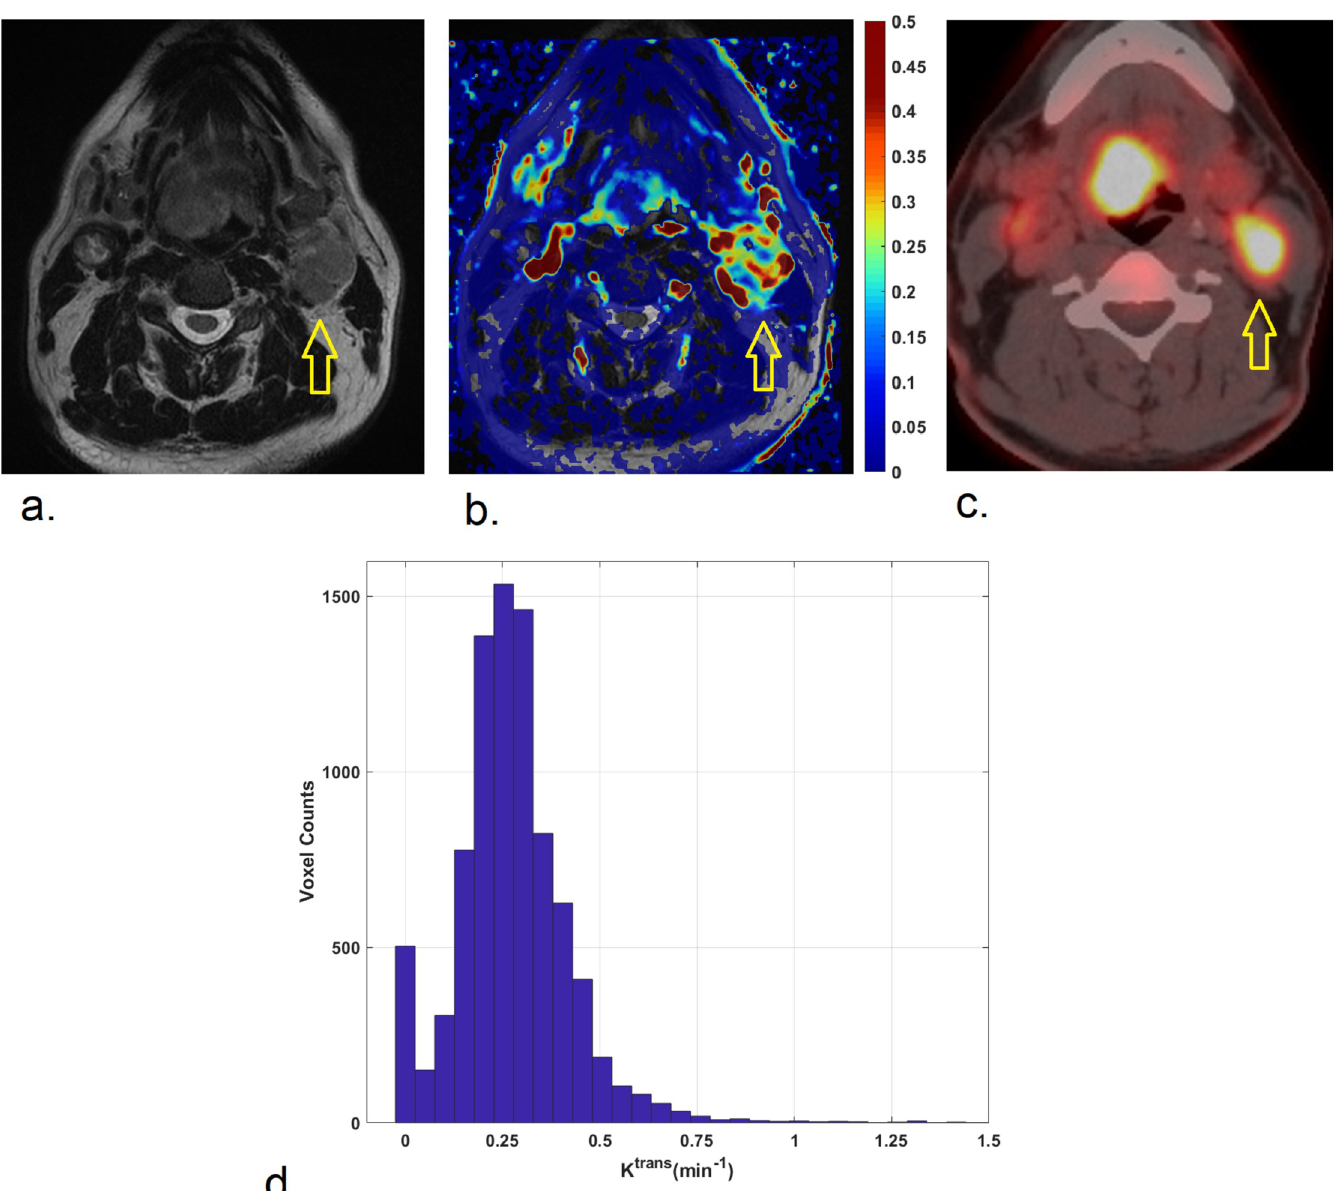
Fig 1. 53-year-old man affected by HPV-positive oropharyngeal squamous cell carcinoma of the base of the tongue with a large metastatic lymph-node in the left IIa level, as shown on axial T2-weighted image (a). K trans map (b) indicates heterogeneous K trans levels in the metastatic lymph-node with a low median value of 0.27 min -1 . Correspondently, a high 18 F-FDG uptake (SUV max : 14.48; SUV peak : 10.5; SUV mean : 8.76) was found, as illustrated in 18 F-FDG PET/CT image (c). Histogram of K trans values within the entire lymph node is shown (d).